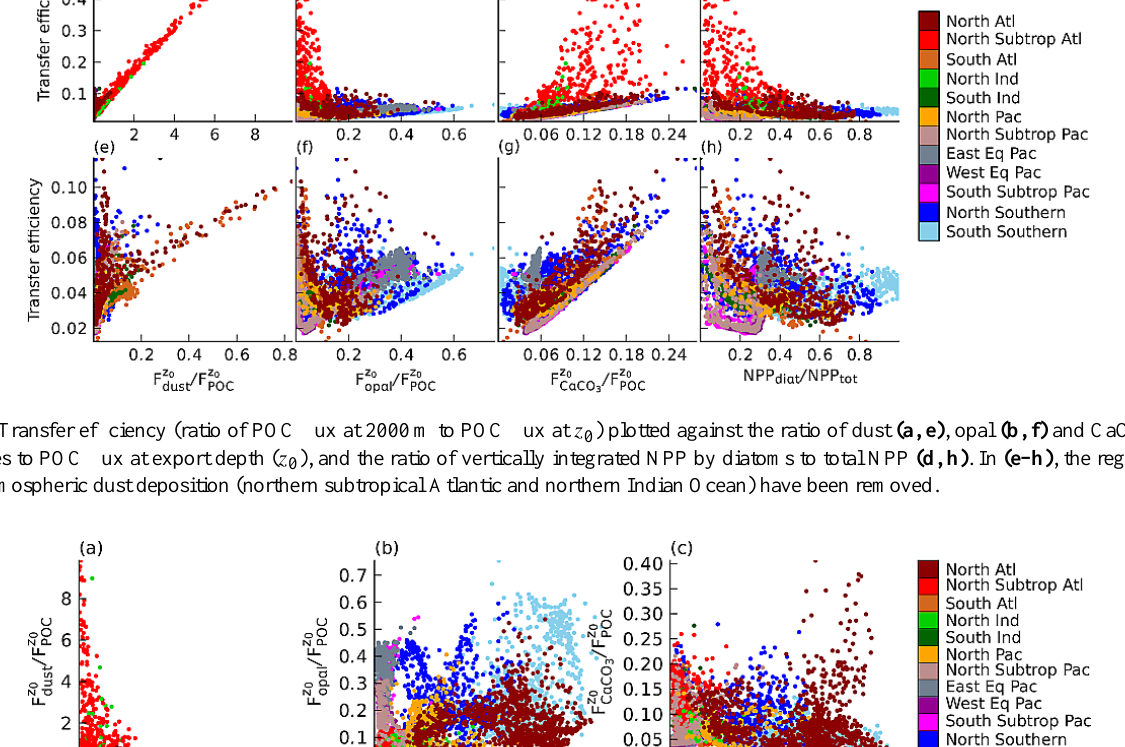
) of a 12-month climatology of NPP NPP